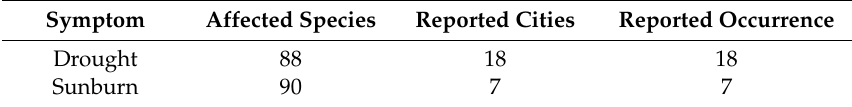
Table 1. Summary of impacts caused by high temperatures on urban tree species in China.